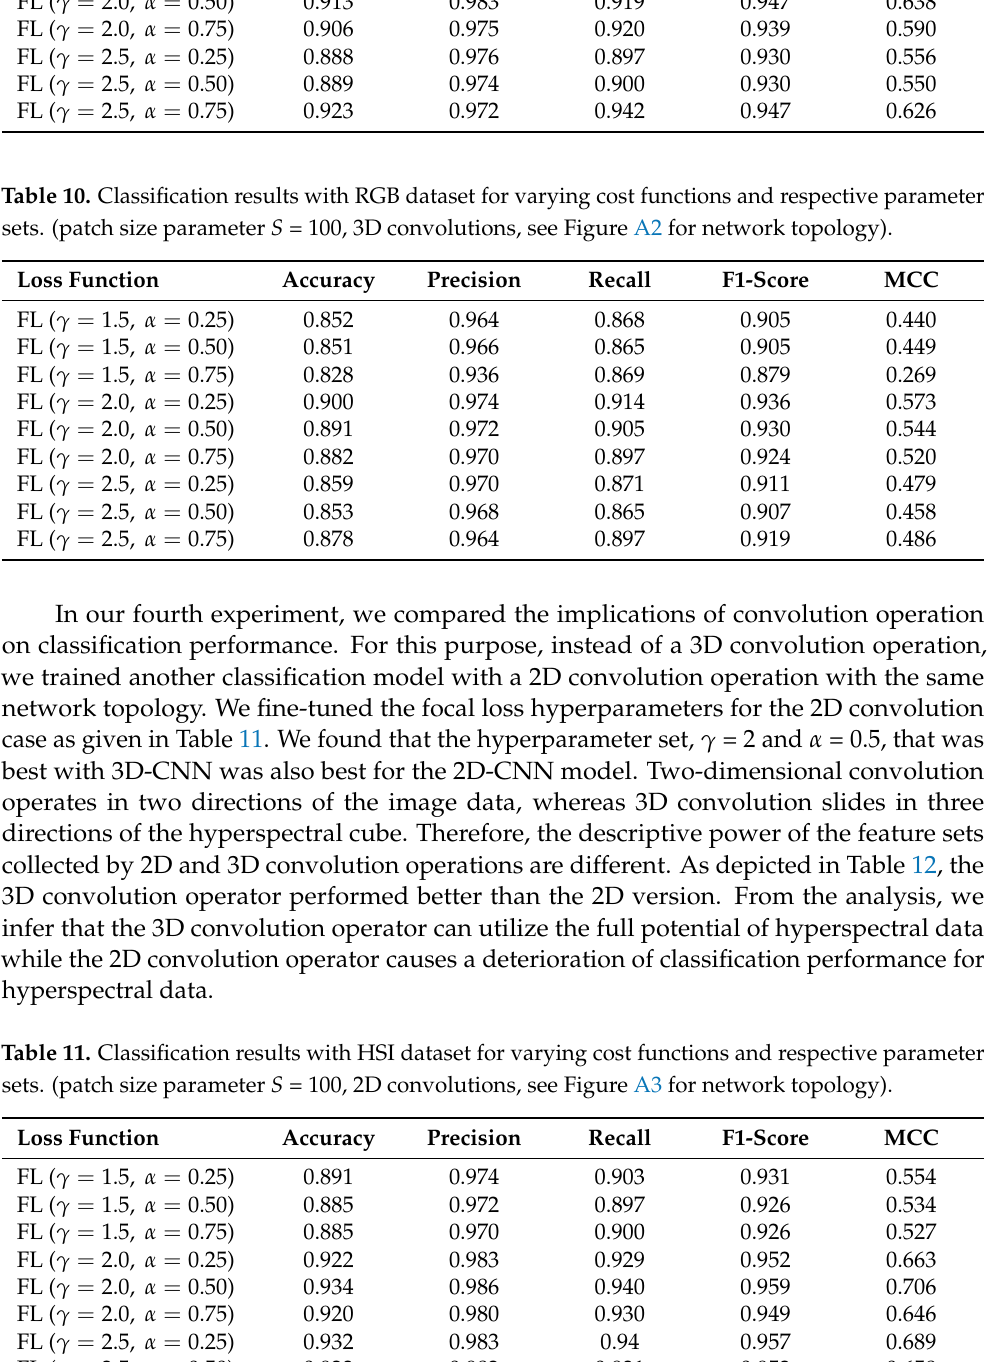
Table 9. Classification results with PCA-3 dataset for varying cost functions and respective parameter sets. (patch size parameter S = 100, 3D convolutions, see Figure A2 for network topology). Loss Function Accuracy Precision Recall F1-Score MCC FL ( γ = 1.5, α = 0.25)